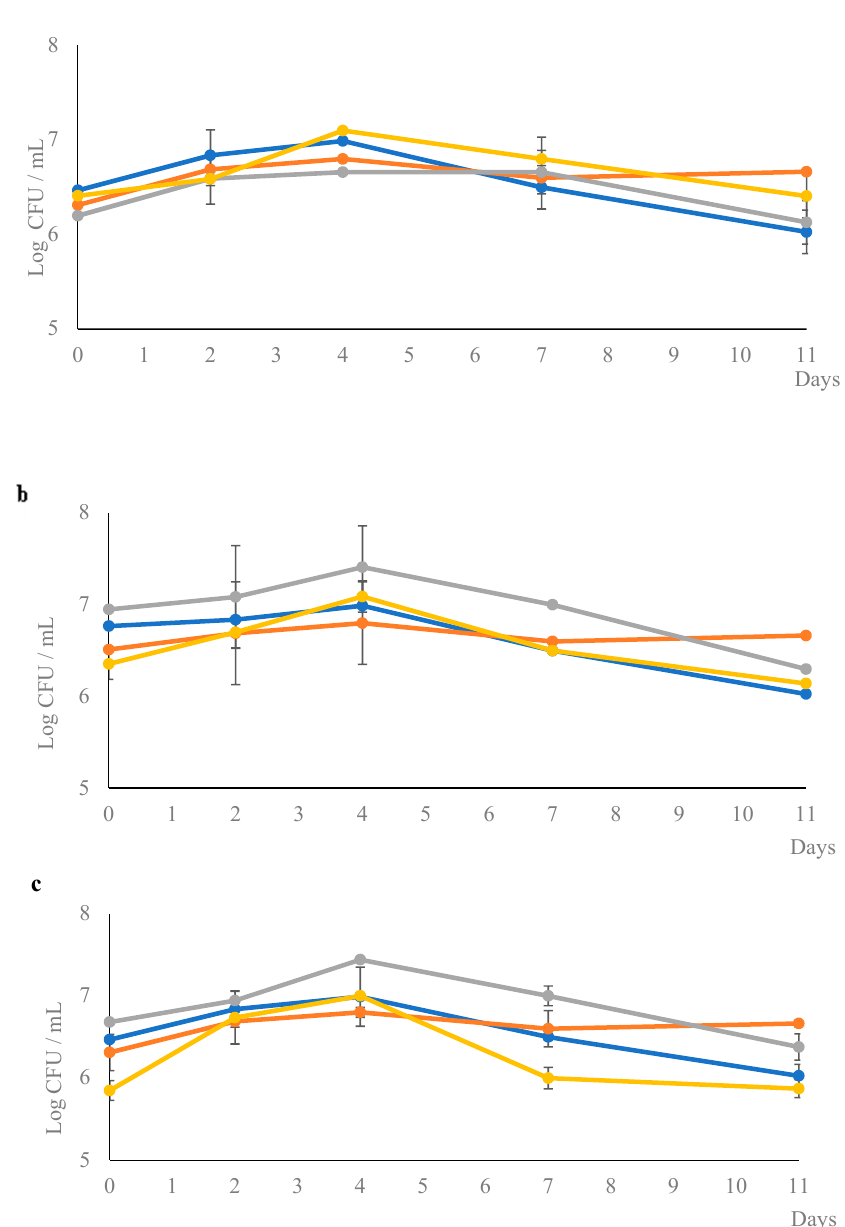
Figure 3. Growth kinetics of W. anomalus in pure and mixed fermentation. Pure cultures of W. anomalus ( ) and S. cerevisiae ( ) and for the mixed fermentation with S. cerevisiae ( ) and W. anomalus ( ) individually in the mixed cultures at 1:1 ( a ), 1:10 ( b ) and 1:20 ( c ).